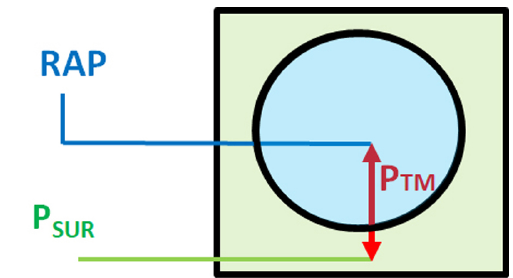
Figure 1: Transmural pressures. Schematic depiction of the right atrium within the thorax and pericardium. In clinical routine the in- tracavitary pressure RAP is measured with fluid filled catheters against the atmosphere. The transmural pressure refers to the pressure difference between the inside of the right atrium and the surrounding pressure in the thoracic cavity (pericardial pressure [P SUR] ), measured to atmosphere). The transmural pressure (P TM = RAP – P SUR ) is the working pressure of the heart chambers and blood vessels within the thorax. The same principle applies for the transpulmonary pressure (alveolar [P AL ] minus pleural pressure [P PL